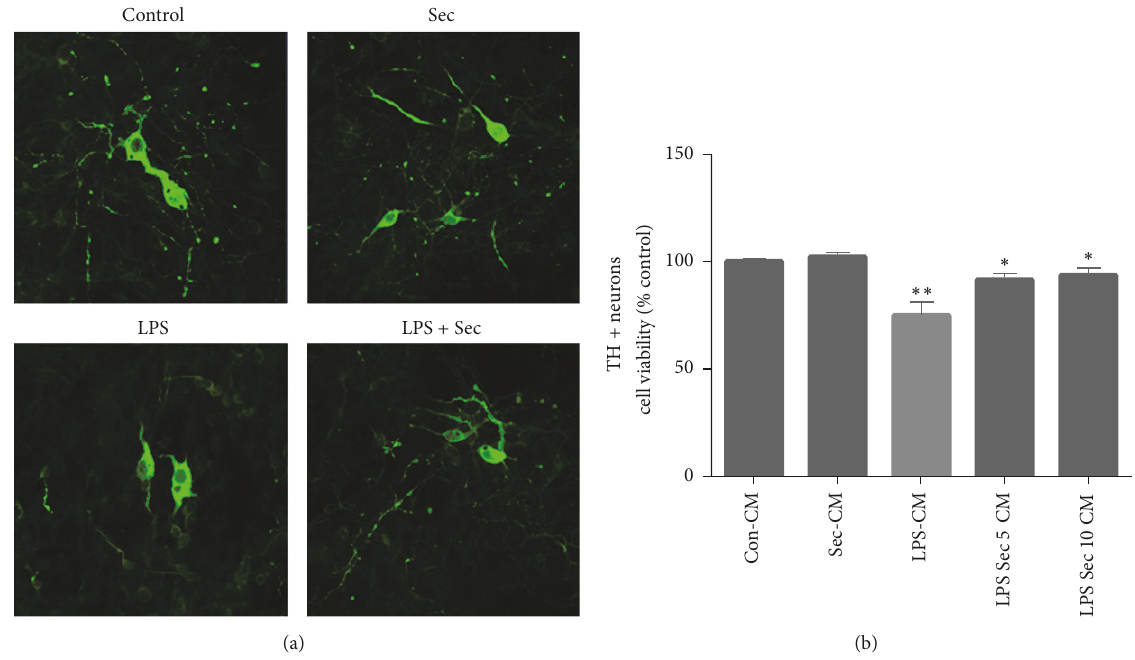
Figure 7: Securinine protects primary mesencephalic dopaminergic neurons through inhibition of BV2 cells activation. BV2 cells were stimulatedwithLPS(500 ng/mL) ± securinine(10 𝜇 M)for24h.CMfromcontrol(BV2-CM),securinine-treated(Sec-CM),LPS-treated(LPS- CM), and LPS/securinine-treated (5 and 10 𝜇 M; LPS + Sec 5 𝜇 M-CM, LPS + Sec 10 𝜇 M-CM) BV2 cells was added to primary mesencephalic cultures. After 72 h, cultures were immunostained for TH + neurons (a) and the number of TH + neurons was counted (b). Data are expressed as mean ± SD, 𝑛 = 4 ; ∗∗ 𝑃 < 0.01 , compared with control-CM group, ∗ 𝑃 < 0.05 , compared with LPS-CM group.